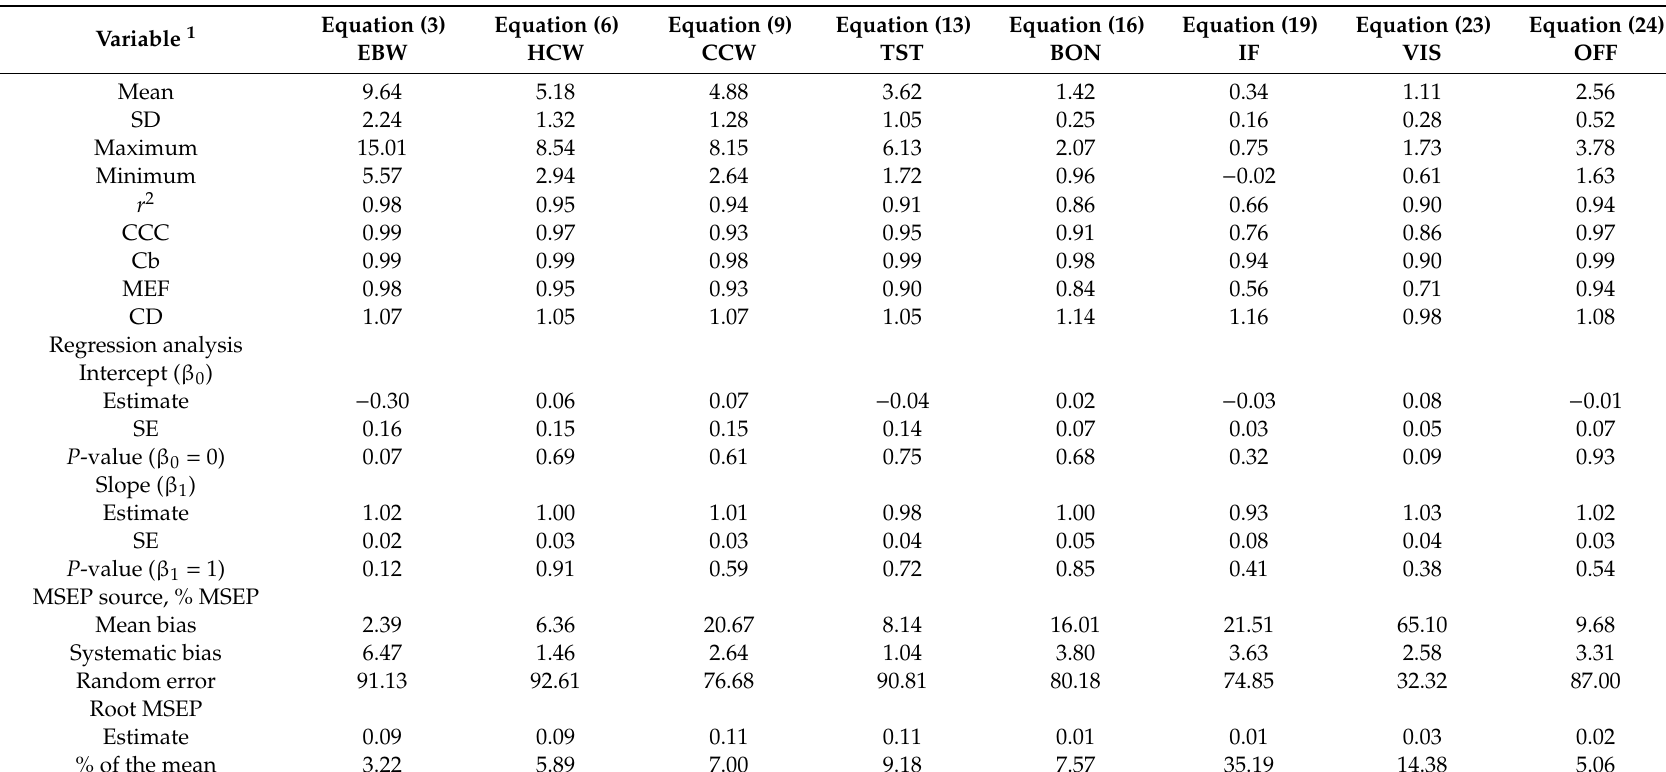
Table 4. Mean and descriptive statistics of the accuracy and precision of the equations for predicting carcass traits in suckling hair lambs using body measurements. Variable 1